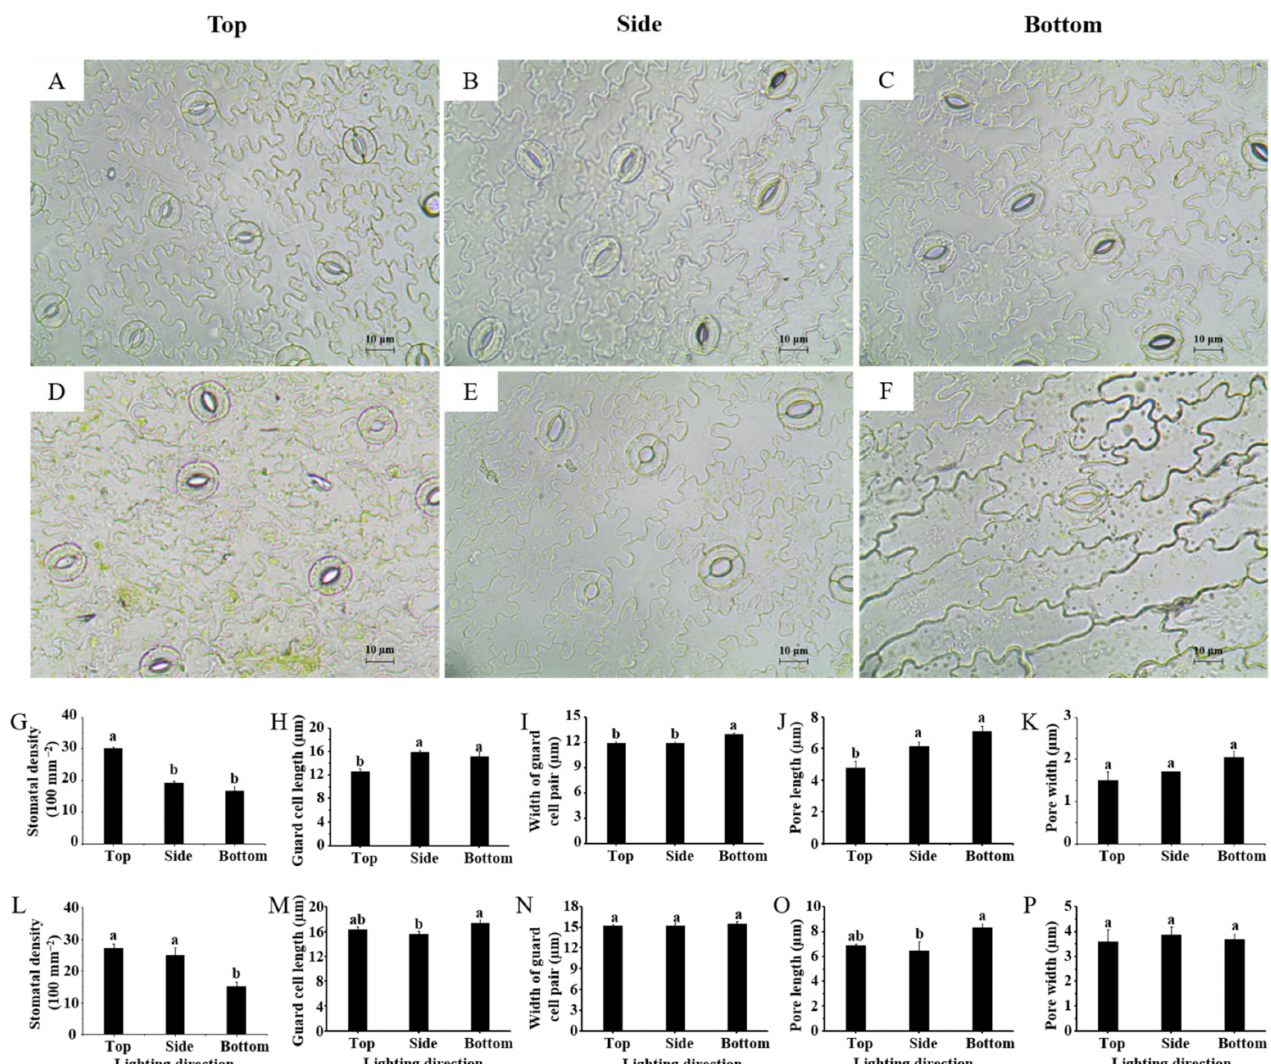
Figure 3. Stomatal micrographs of lettuce Caesar Green ( A – C ) and Polla ( D – F ) leaves, and stomatal density, guard cell length, width of guard cell pair, pore length and width of lettuce Caesar Green ( G – K ) and Polla ( L – P ). Vertical bars indicate the means ± stand error ( n = 3). Different small letters indicate the significant separation within treatments by the Duncan’s multiple range test at p ≤ 0.05. Bars indicate 10 µ